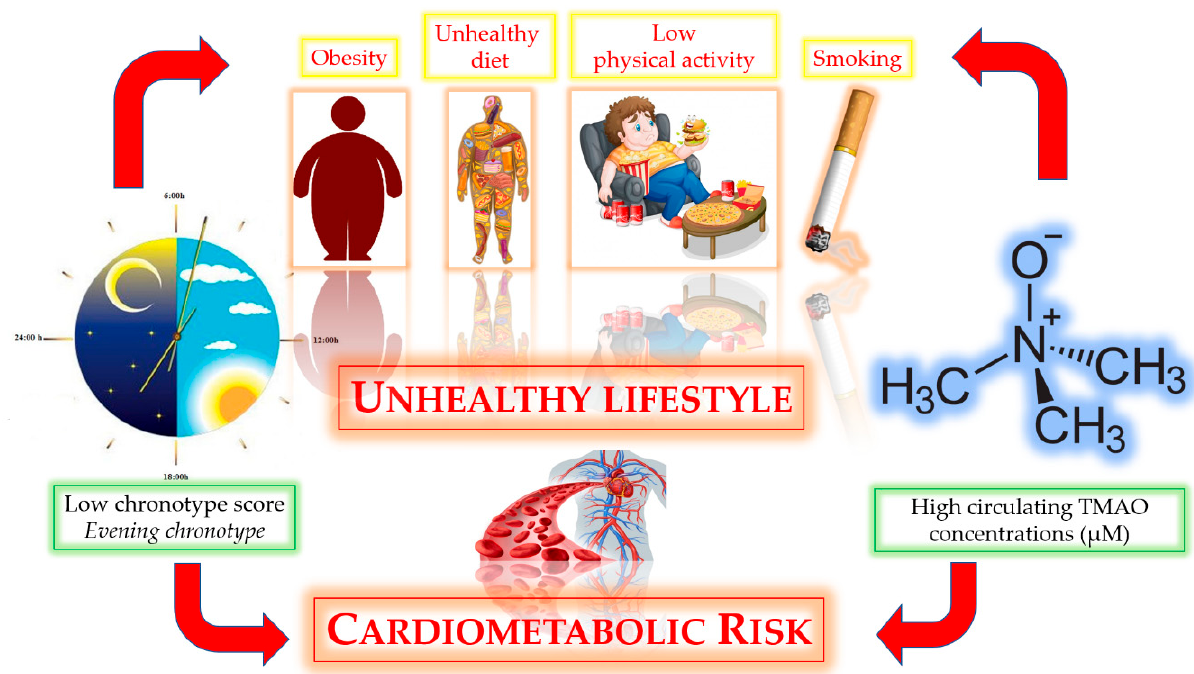
Figure 4. The possible bidirectional relationship between the evening chronotype and high circulating TMAO concentra ‐ tions.